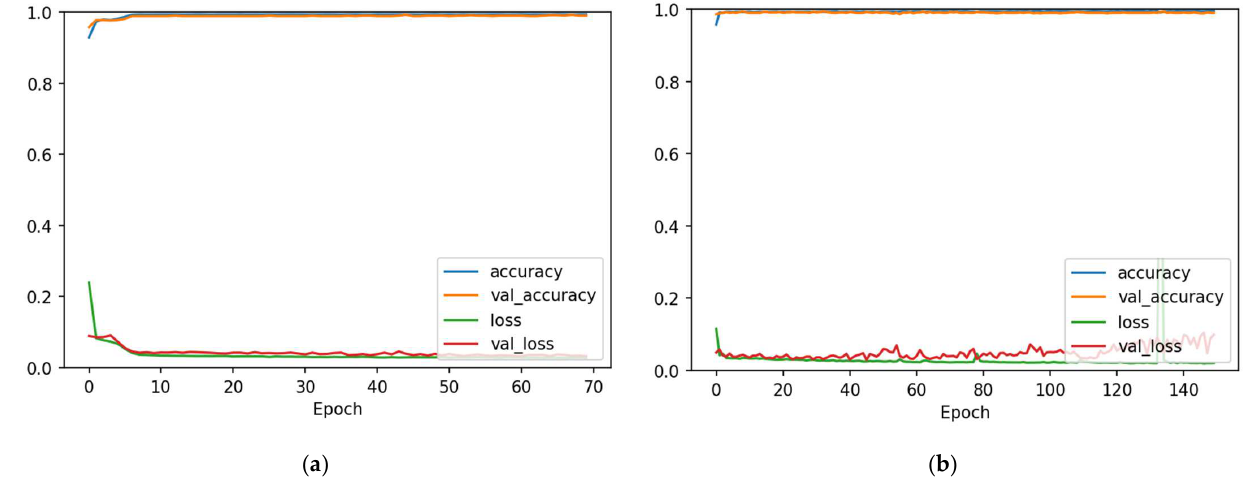
Figure 13. Accuracy and loss after data augmentation. ( a ) 1D-CNN model; ( b ) Bi-LSTM model. The effectiveness of the 1D-CNN and Bi-LSTM models in detecting HD was then Table 7. Performance comparison before and after using the GAN model on the Cleveland dataset. assessed using the 2000 testing samples. The Bi-LSTM model achieved better results as compared to the 1D-CNN model, including an accuracy of 99.3%, a specificity of 99.2%, a Before Augmentation and PCA After Augmentation and PCA sensitivity of 99.3%, and an F1-score of 99.2%, as is shown in Table 7. Additionally, the prediction time for 61 samples was recorded before and after PCA was used to see the impact of feature reduction on the models’ computation time. When compared to the